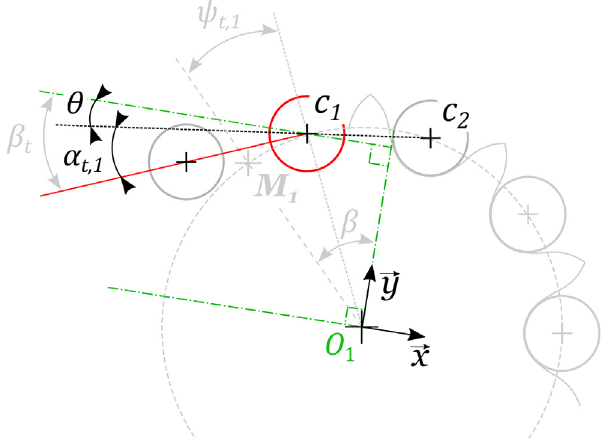
Fig. 6. Calculation of a t ,1